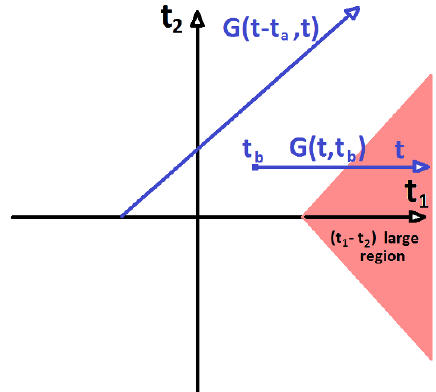
Figure 12. The large t limit of greater Green’s function G > ( t; t b ) is calculated in the large ( t 1 (cid:0) t 2 ) region of the retarded Green’s function G R ( t 1 ; t 2 ). Moreover, in this region, the system has more or less thermalized. Hence, (cid:13) It = (cid:13) ret